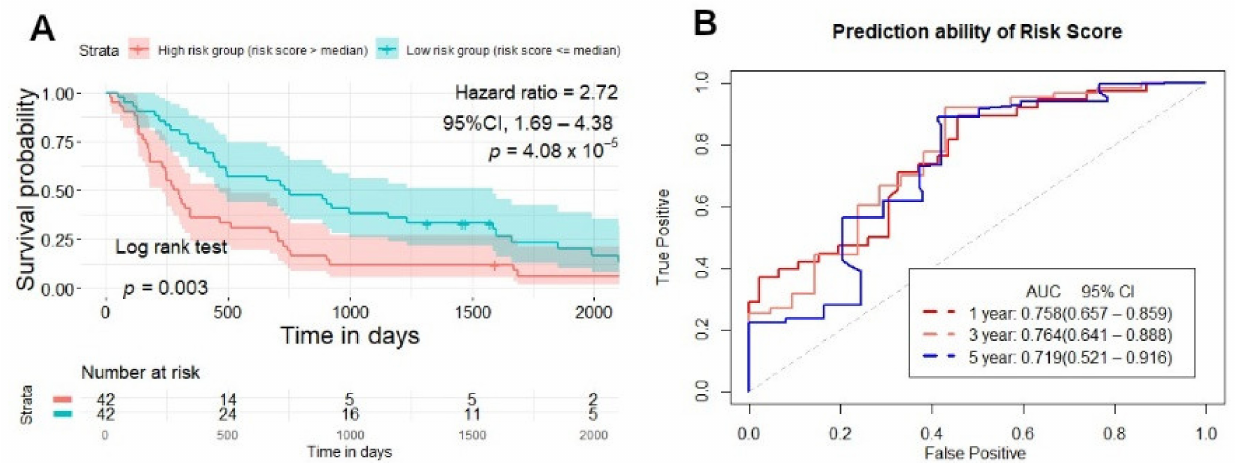
Figure 6. Survival prediction of risk score generated from CT-based radiomics signatures in the testing set. ( A ) Kaplan– Meier curves stratified patients into two groups: high and low-risk group by risk score in the testing set. ( B ) ROC curves illustrate the prediction ability of risk score for overall survival prediction in 1, 3, 5 years in the testing set.